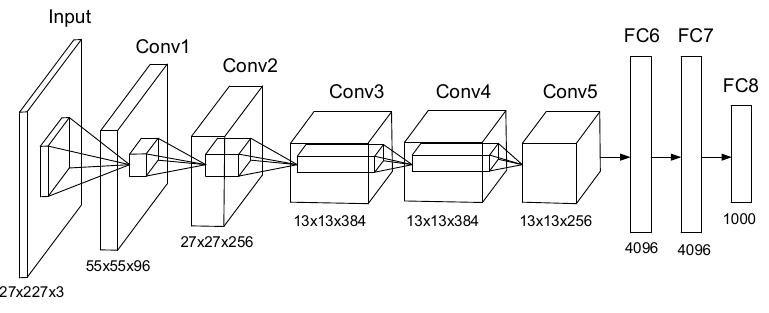
Figure 1. Architecture of AlexNet.